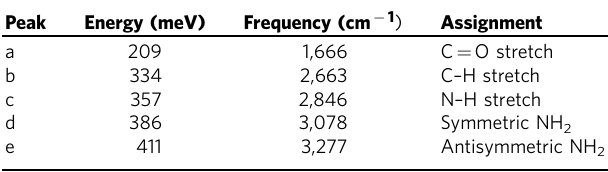
energy loss, D E such that: D E o ð 1 Þ ¼ q z ¼ k i mv 2 v where v is the electron velocity, m is the electron mass, k i is the initial wavevector for the fast electron and o ¼ D E/ : is the frequency of vibration. NATURE COMMUNICATIONS|7:10945|DOI: 10.1038/ncomms10945|www.nature.com/naturecommunications